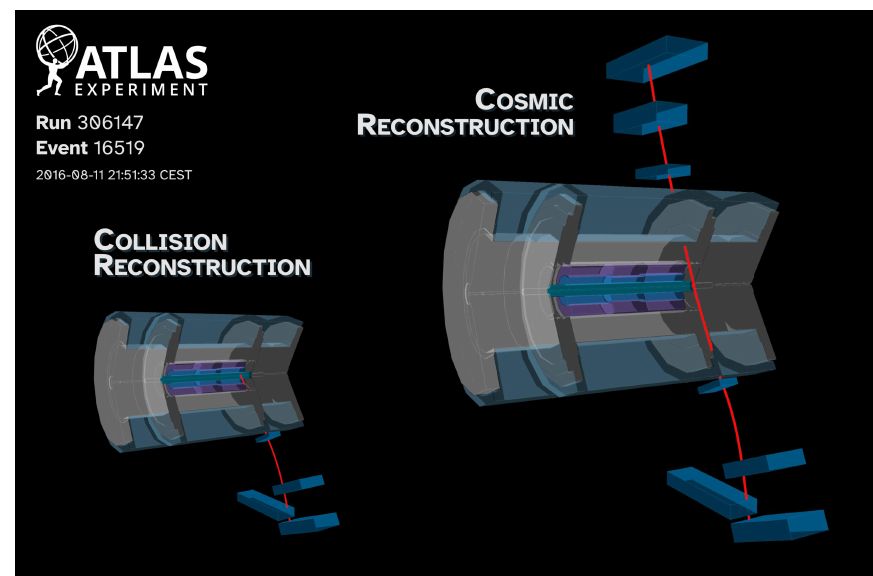
Figure 1 . Event display showing an event from the cosmic sample reconstructed using collision reconstruction (left) and cosmic reconstruction (right) configurations. The red line represents the extrapolated muon path based on the hits induced in the MDTs (blue). For readability, only the MDT chambers with associated hits are shown. A cut-away view of the LAr and Tile calorimeters is included for orientation. By using cosmic reconstruction mode the muon-segment track recon- struction requirements are loosened, increasing the efficiency for identifying muon segments induced by cosmic rays. With collision reconstruction settings, only the lower half of the cosmic-ray muon track is reconstructed, whereas in cosmic reconstruction mode the upper leg is reconstructed as